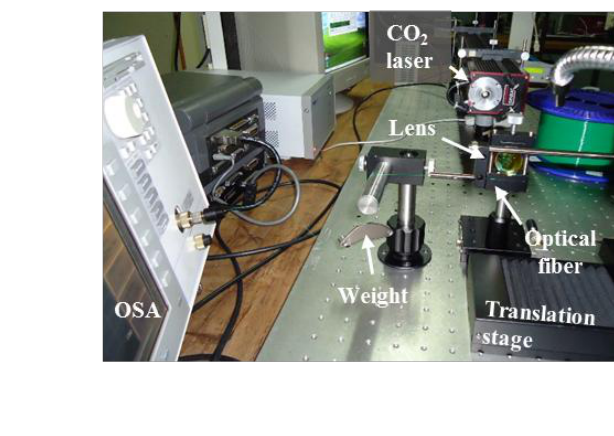
laser writing a 2